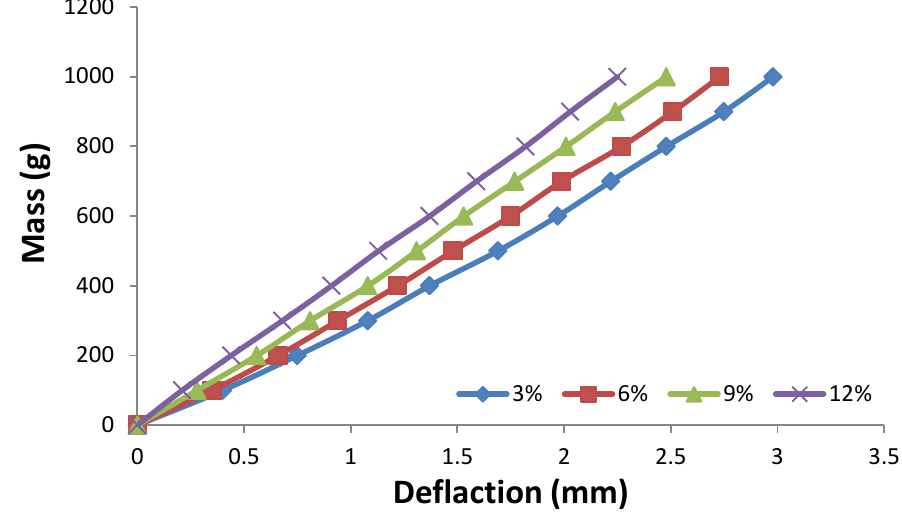
Fig. 4: Mass vairation with different concentrations of MgO after immersion in diluted sulfuric acid for 10 days.